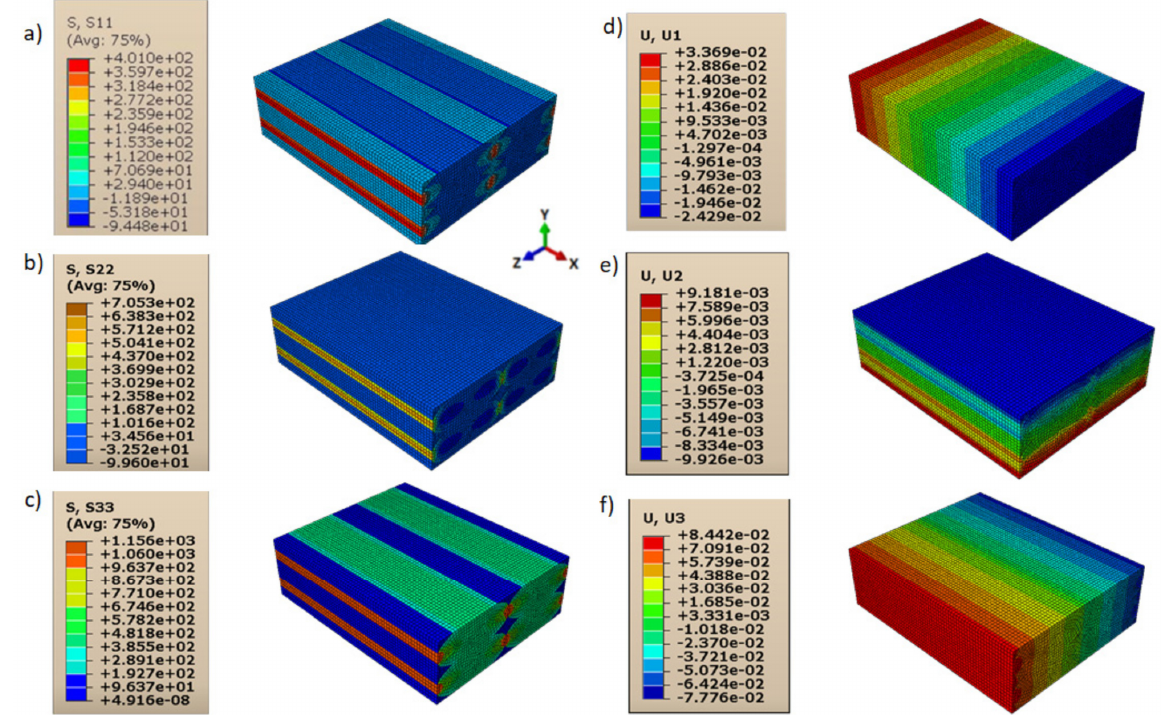
Figure 12. Load cases to evaluate E 33 : ( a ) stress in direction 11; ( b ) stress in direction 22; ( c ) stress in direction 33; ( d ) displacement in direction 11; ( e ) displacement in direction 22; ( f ) displacement in direction 33.